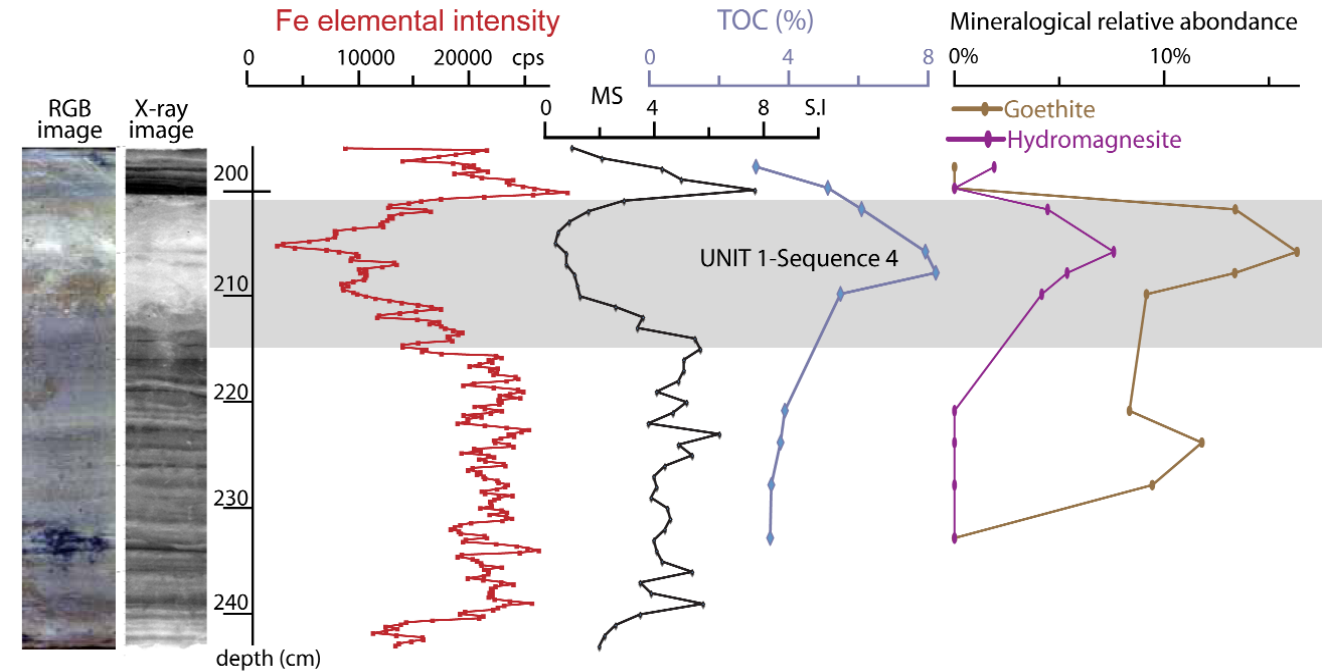
Figure 12. The bottom event in the core AT2007LG, and from left to right: RGB image and X-ray picture, Fe intensity, magnetic susceptibility, TOC, relative abundance of goethite and hydromagnesite in a quantification including quartz, plagioclase, clay, calcite, dolomite, hydromagnesite, hematite and